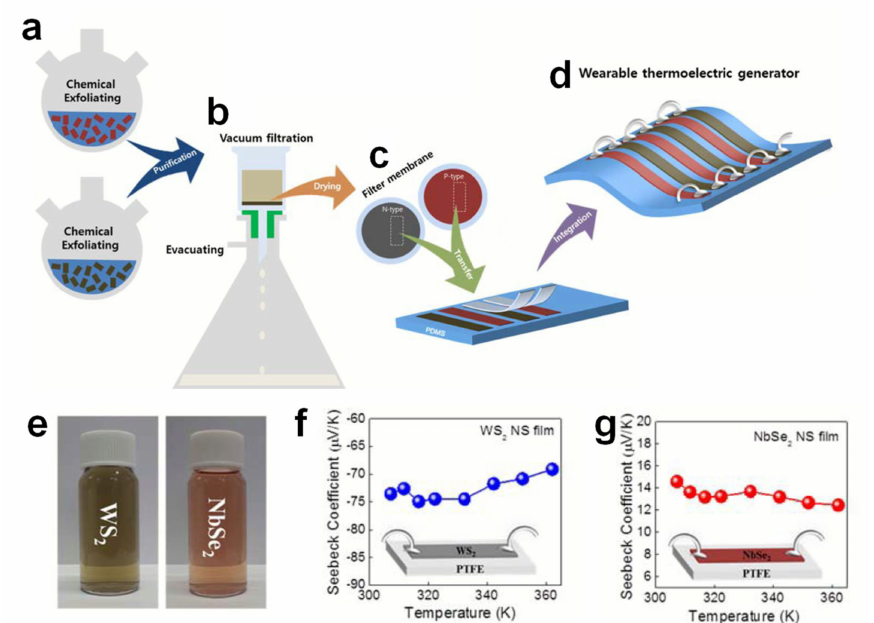
Figure 13. Chemically exfoliating TMD nanosheets and manufacturing a wearable thermoelectric generator using TMD nanosheets: ( a ) preparation of chemically exfoliated TMD, ( b ) vacuum filtration of TMD nanosheets using a membrane filter, ( c ) transfer of a vacuum-filtered TMD nanosheet film to a PDMS substrate using a contact printing method, and ( d ) the connection between Ag wire and thermoelectric film using Ag paste. ( e ) WS 2 and NbSe 2 dispersed in aqueous solution, With graphical representations of thermoelectric properties from 300 K to 360 K for chemically exfoliated ( f ) WS 2 and ( g ) NbSe 2 . Reproduced with permission from [76], Copyright 2016, Royal Society of